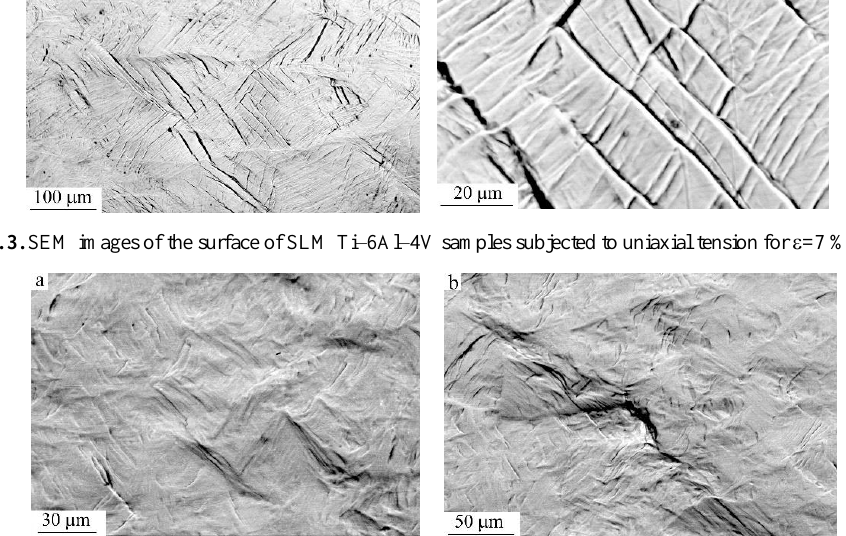
Fig. 4. SEM images of the surface of EBM Ti–6Al–4V samples subjected to uniaxial tension for  = 7 (a) and 13 %